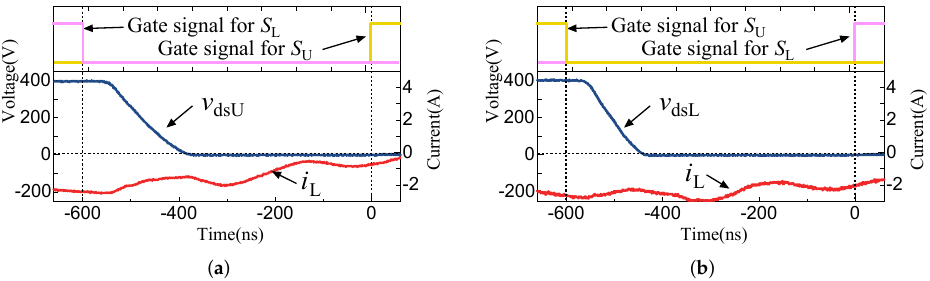
Figure 11. Zoomed waveforms around critical switching transients with enough margin of initial switching current and dead-time as example points ( a ) marked as E, ( b ) marked as F in Figure